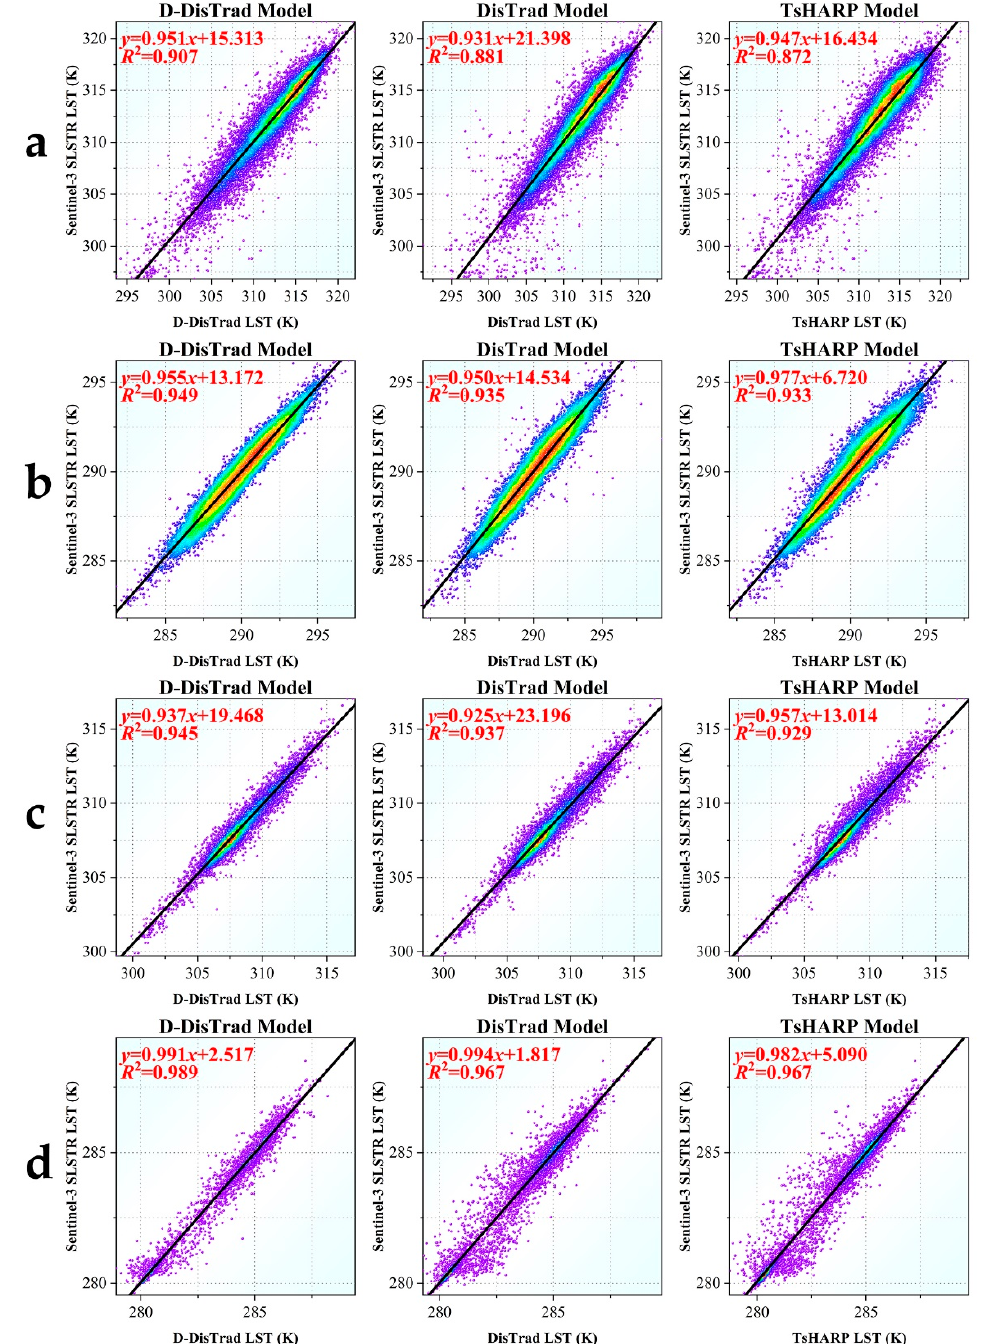
Figure 9. Relationship between three downscaling results aggregated to the 900 m resolution and Sentinel-3 SLSTR LST: ( a ) site 1, Beijing; ( b ) site 2, Guilin; ( c ) site 3, Xi’an–Xian Yang; ( d ) site 4, Taihu River Basin. The solid black line represents the regression line. Table 5. Statistics for the three downscaling results aggregating to 900 m in comparison with the SLSTR LST data for the 4 sites.